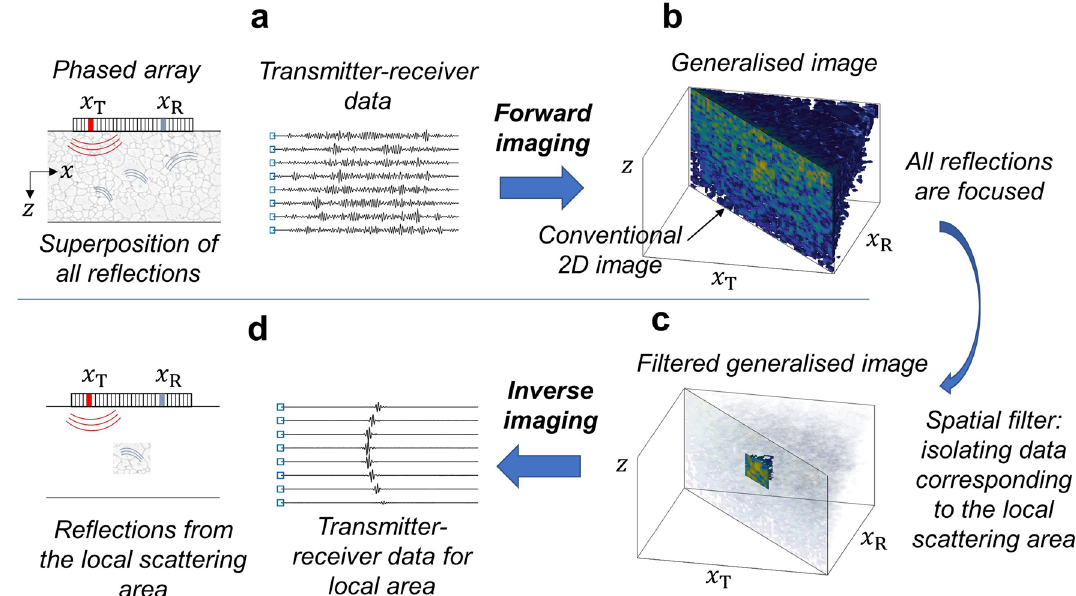
Figure 1. Reversible imaging concept. ( a ) Transmit–receive array data are collected by firing each array element and using all elements on reception. The data represents superposition of reflections from multiple scatterers in the material. ( b ) Transmit–receive data is converted into the generalised image with independent transmit and receive focusing points x T and x R . The data corresponding to each scattering area is localised in the vicinity of the main diagonal x T = x R . ( c ) A spatial filter is applied to the generalised image in order to isolate responses from the local scattering area. ( d ) The filtered generalised image is then converted back into array data, providing isolated transmit–receive signals for the local scattering